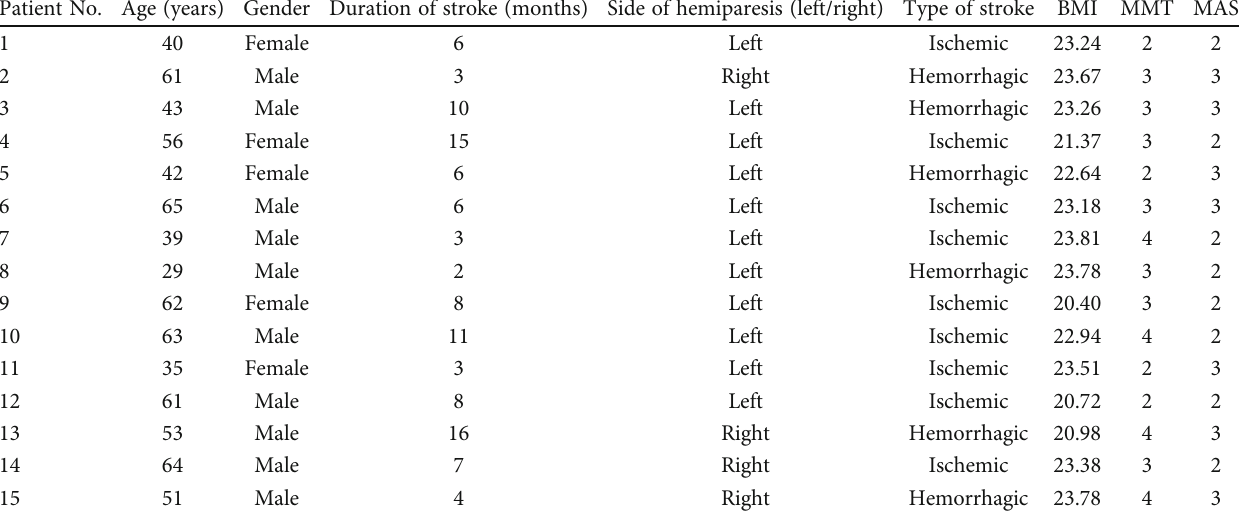
Table 1: Subject demographic